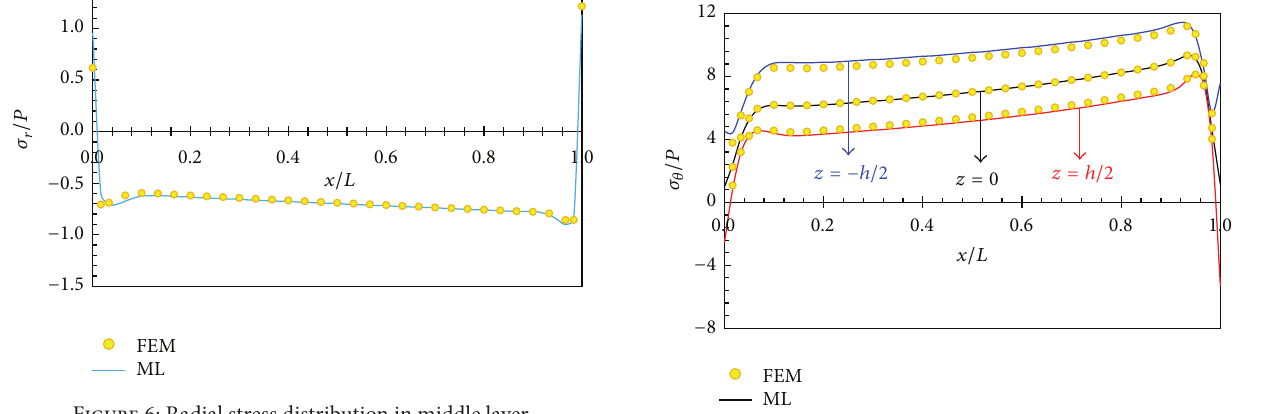
Figure 9: Circumferential stress distribution in different layers.